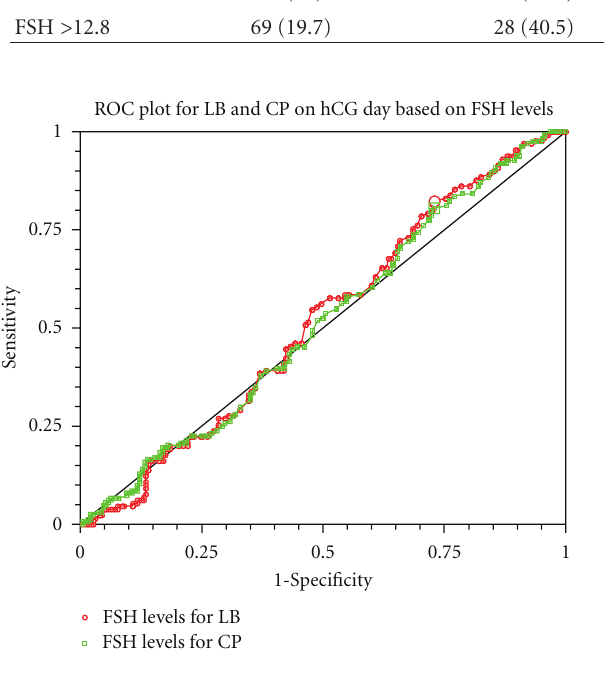
Figure 3: Optimum cut-o ff point selected: 4; area under ROC curve: 0.48; 95% CI: 0.45 to 0.56; sensitivity (95% CI): 0.18; specificity (95% CI):